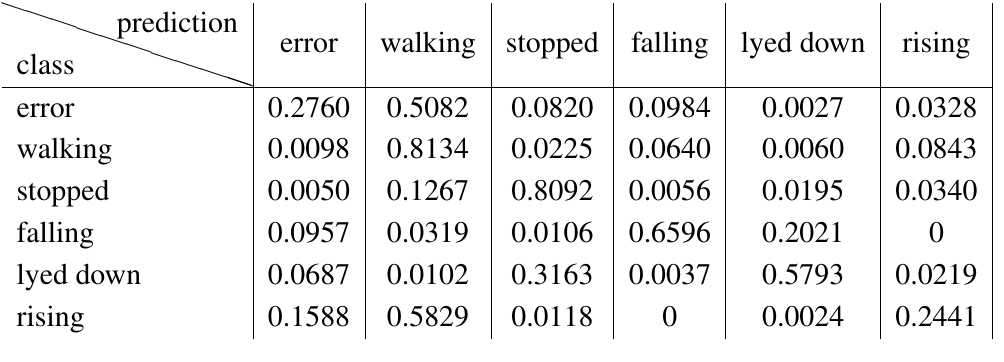
Table 8. Relative Confusion matrix for the HMM generated using BFS to classify the activ- ities walking , stopped , falling , lyed down , rising and error